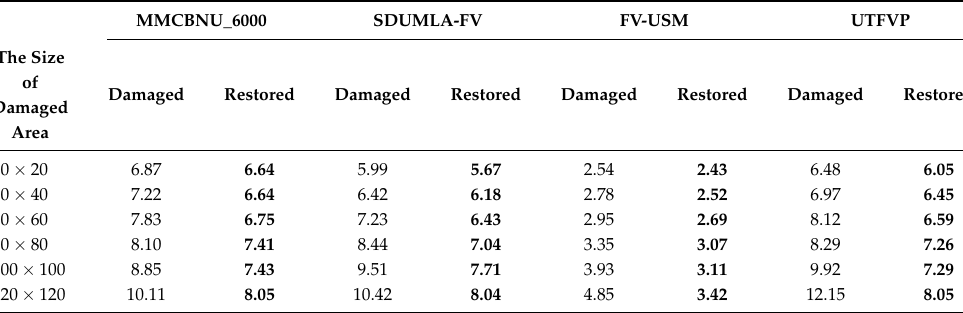
Table 9. EERs (%) of the central damaged area on the different public